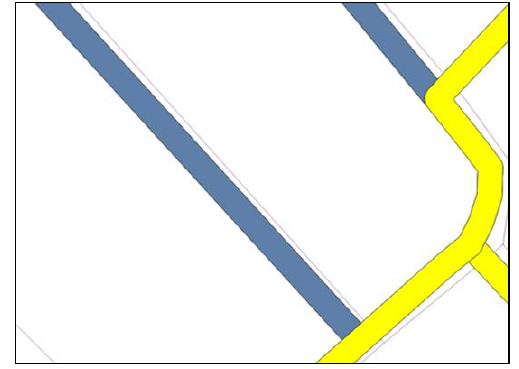
Figure 4. Street spaces affected during pipeline repairs